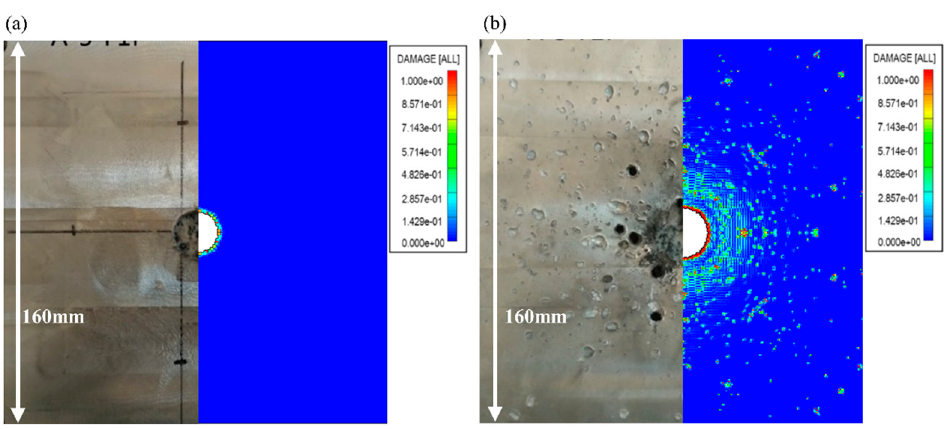
Figure 11. The experiment and simulation damage contours of ( a ) Bumper I and ( b ) Bumper II.